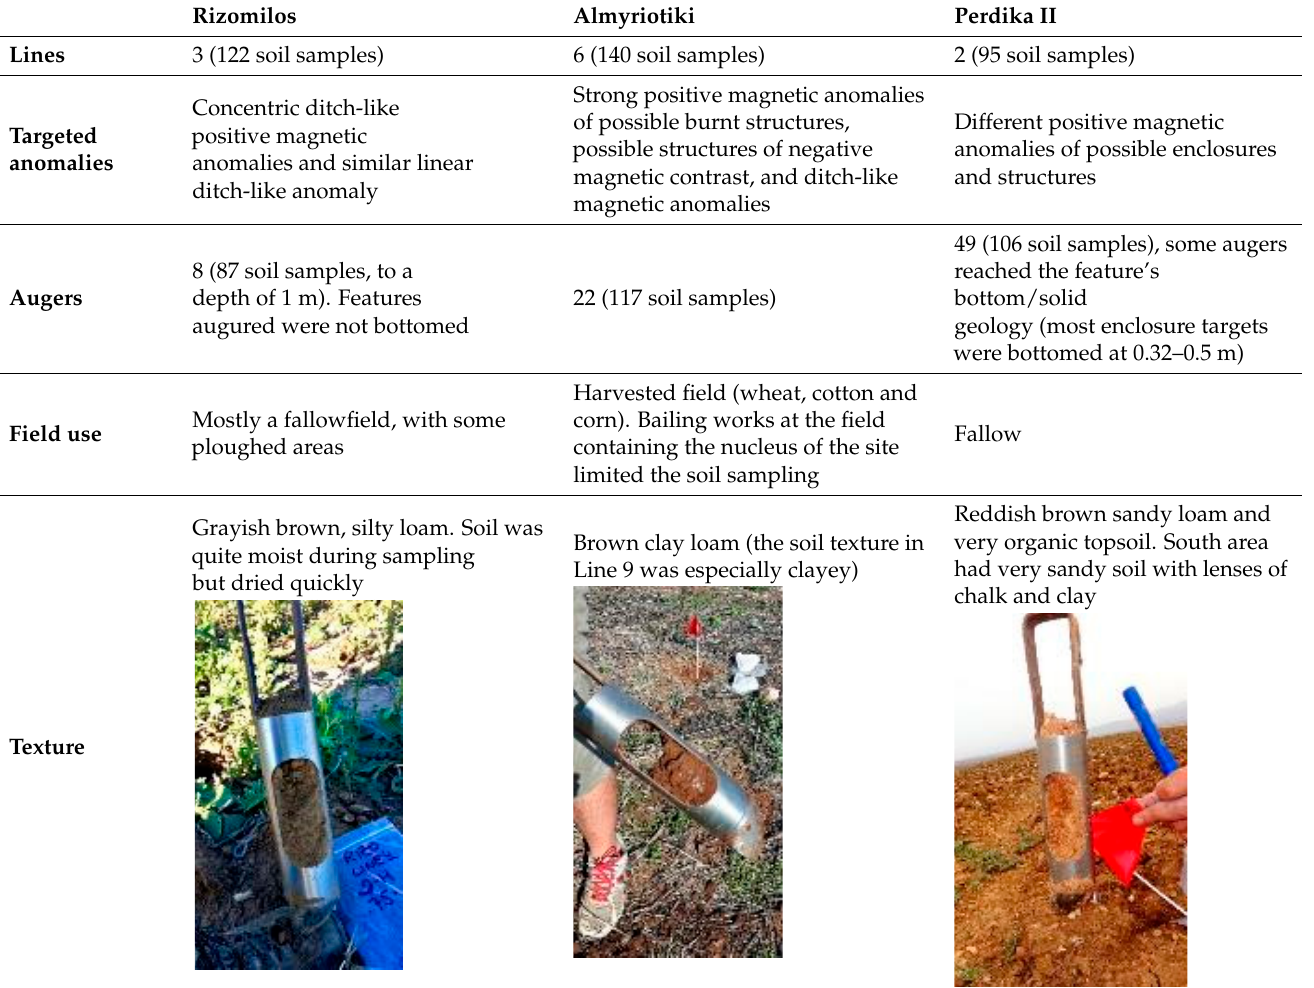
Table 2. General description of the soil samples collected and archaeological targets at the three sites. The location of the sampled lines is in Figure 2.